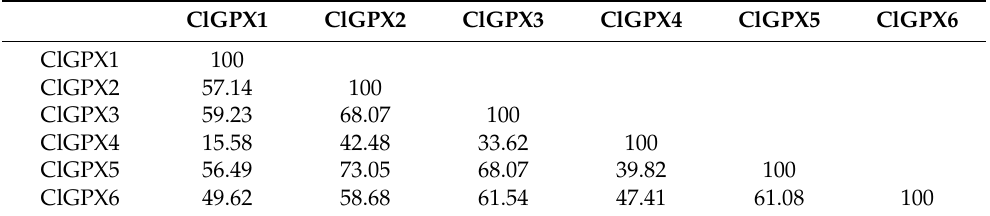
Table 2. The percentage of ClGPX proteins’ amino acid